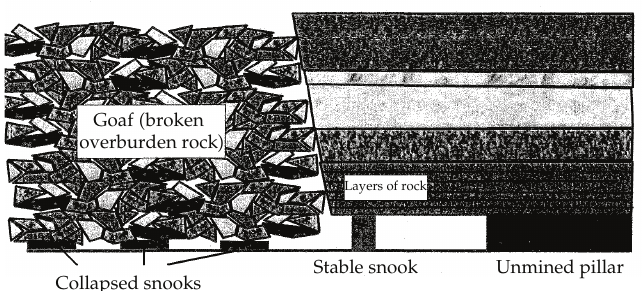
Figure 3: A cross-section of the mine showing failed snooks and goaf, a stable snook, the next pillar to be mined, and the overburden which consists of horizontal layers of rock. Reproduced with permission from N. van der